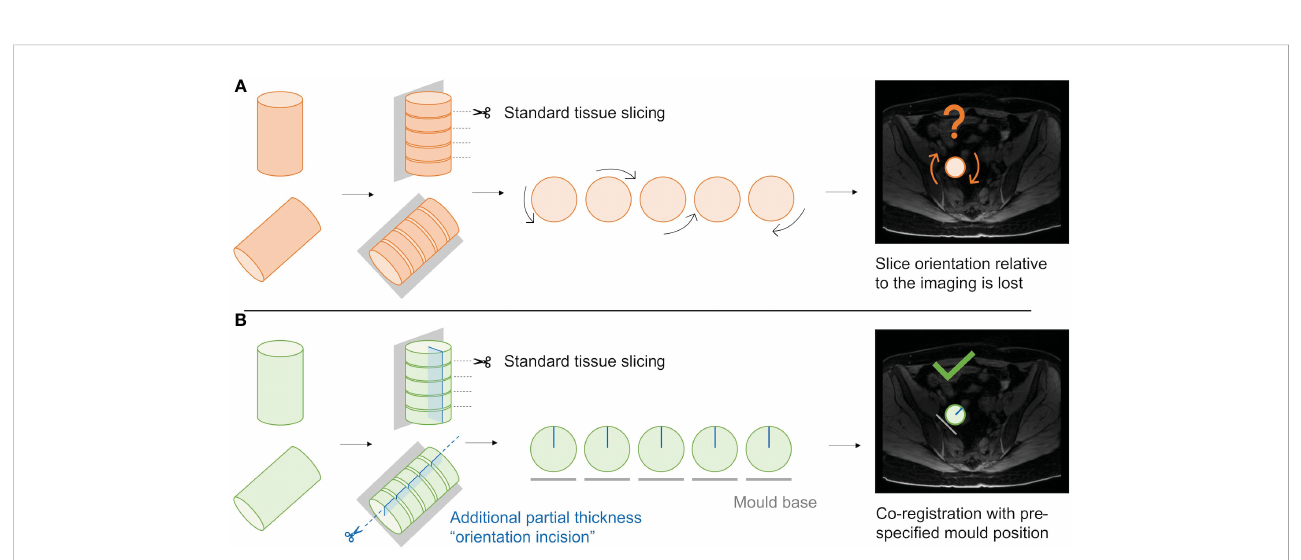
FIGURE 9 Schematic demonstrating the utility of the “ orientation incision ” . (A) ; Without an orientation incision, any rotation of the tissue slices when removed from the mould cannot be quanti fi ed, and co-registration if radiological imaging is lost. (B) ; a partial-thickness orientation incision across tissue slices allows orientation of slices to each other, and to their corresponding coordinates on the radiological